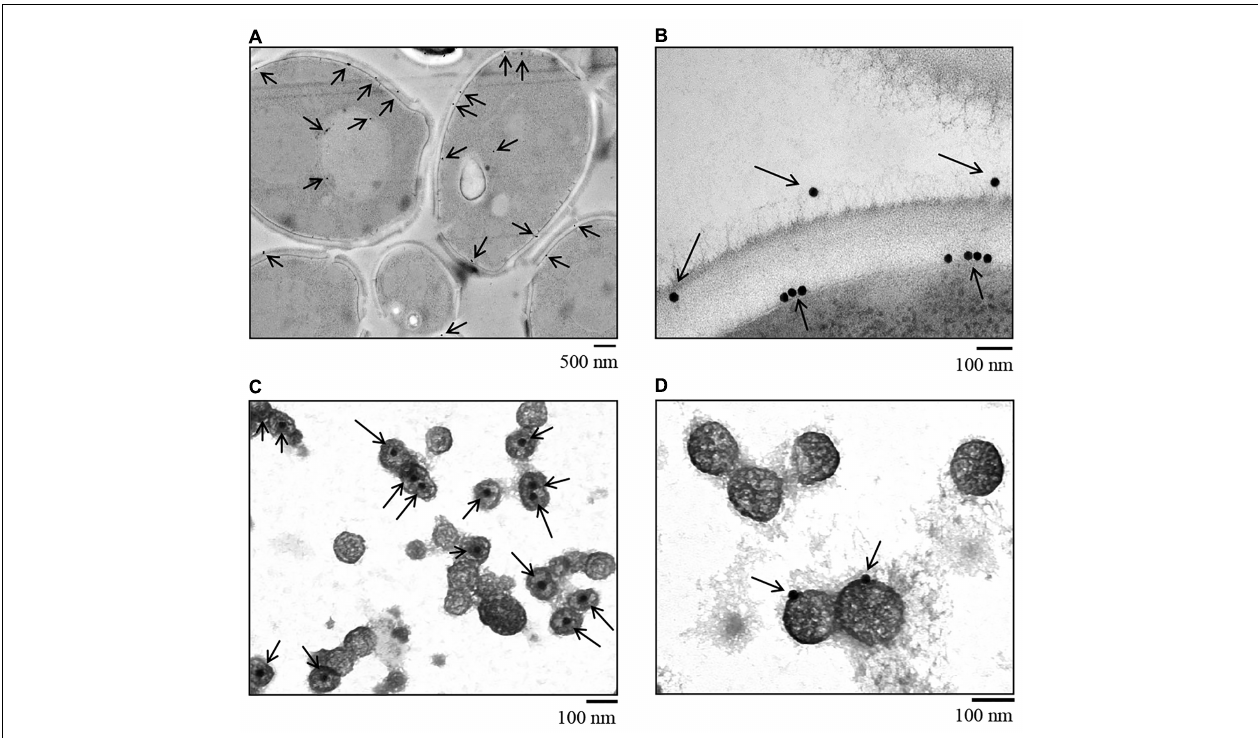
FIGURE 3 | Immunogold staining of C. albicans SN152 grown in physiological low glucose medium (0.1%) after HPF cryofixation visualized by TEM. (A) Intracellular distribution and Hgt1p detection in the cell membrane and cell wall of C. albicans. (B) Zoomed-in view of Hgt1p in the cell membrane and on the cell wall surface. (C) Gold staining of secretory pathway vesicles showing Hgt1p protein in the internal part of the vesicle and (D) on exosomes released by C. albicans to the environment, demonstrating the presence of Hgt1p integrated in the vesicle membrane.